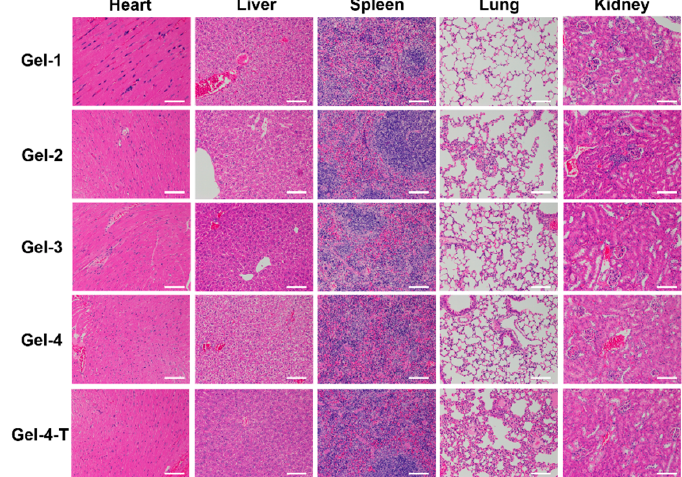
Figure 9. In vivo toxicity assessment of hydrogels. Hematoxylin–eosin (H&E) stained tissue slices (liver, spleen, kidney, heart and lung) of mice injected with hydrogels after 24 h (the white scale bar is 200 µm).